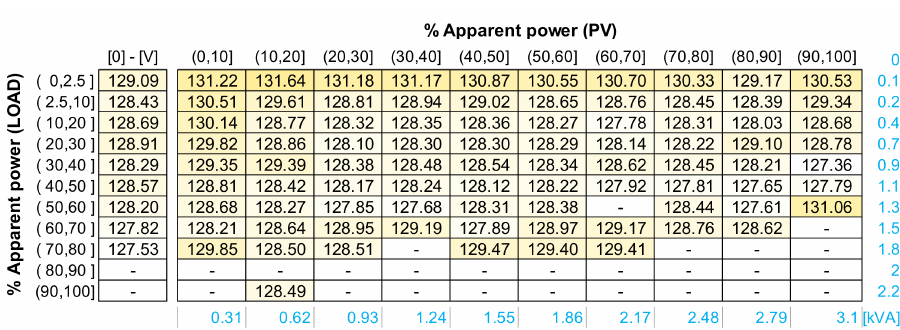
Figure 16. Matrix of average values of Vrms for each scenario of Phase C.